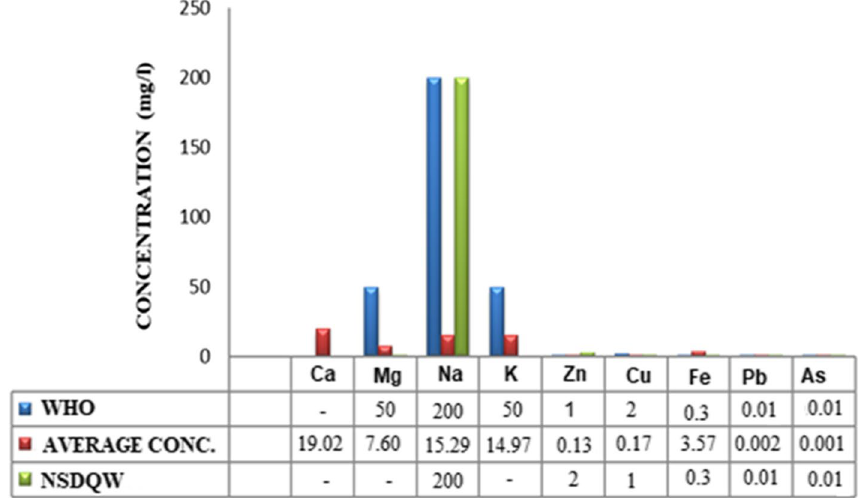
Fig. 2 Bar chart of the permis- sible limits standard for drink- ing water set by the WHO and NSDQW and the ion concentra- tions of the cations and heavy